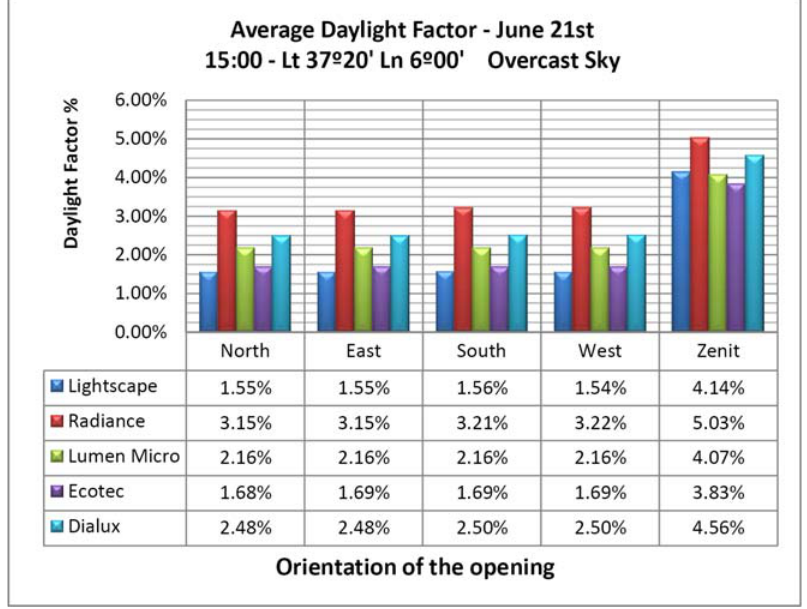
Figure 2. Daylight Factor of Average levels of Illuminance. June 21st, overcast sky.